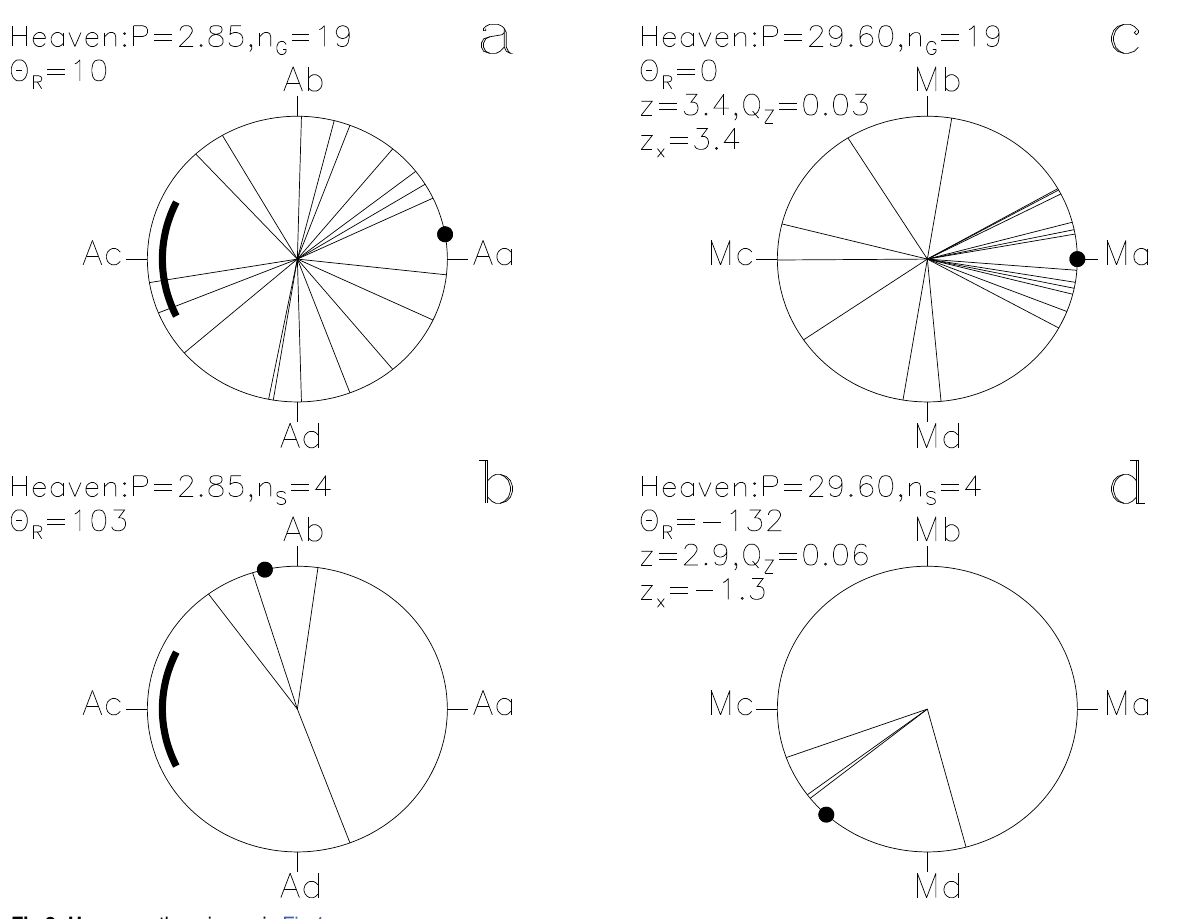
Fig 8. Heaven. otherwise as in Fig